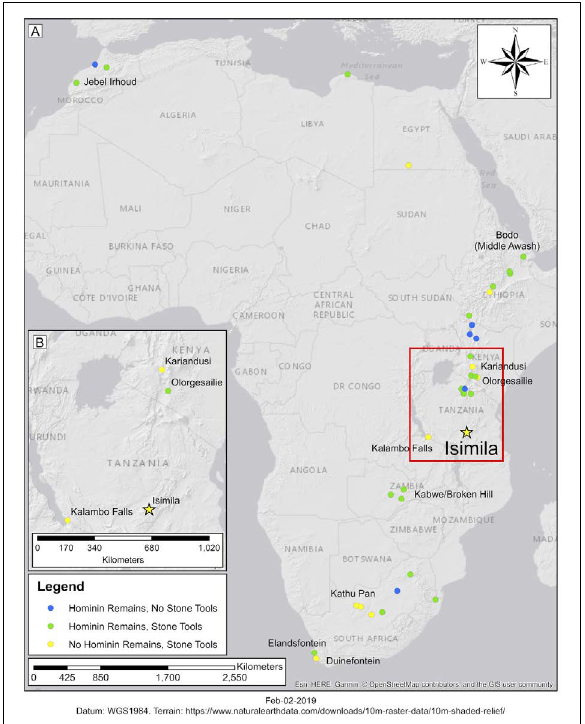
Figure 1: Map of Middle Pleistocene sites in Africa that are either contemporaneous to Isimila or contain similar lithic type/ distribution. Blue points indicate sites with hominin remains with no stone tools, green points indicate sites with hominin remains and stone tools, and yellow points indicate sites with stone tools but no hominin remains. 31